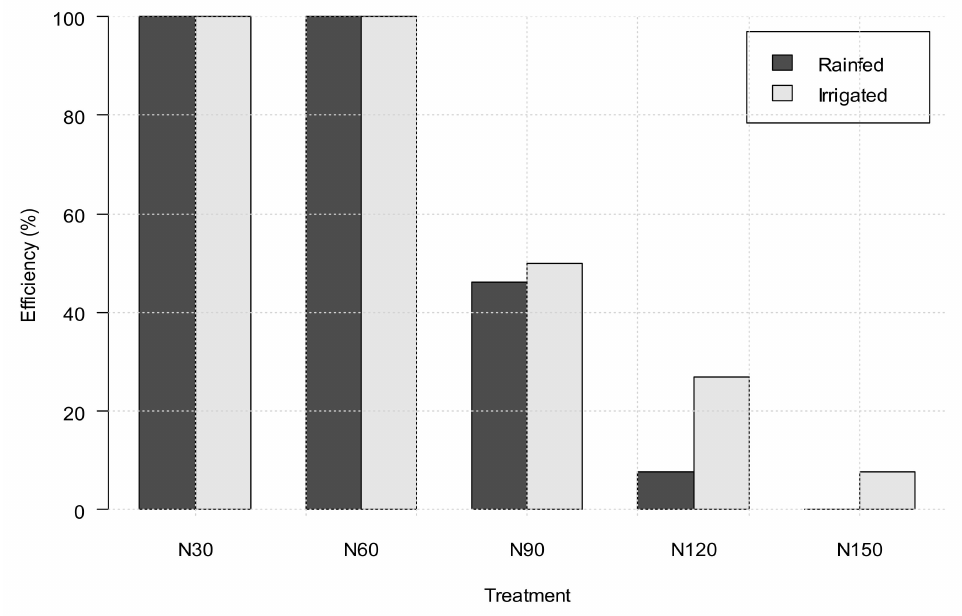
Figure 4. Efficiency of the fertilization of non-irrigated and irrigated plots (1996–2008).